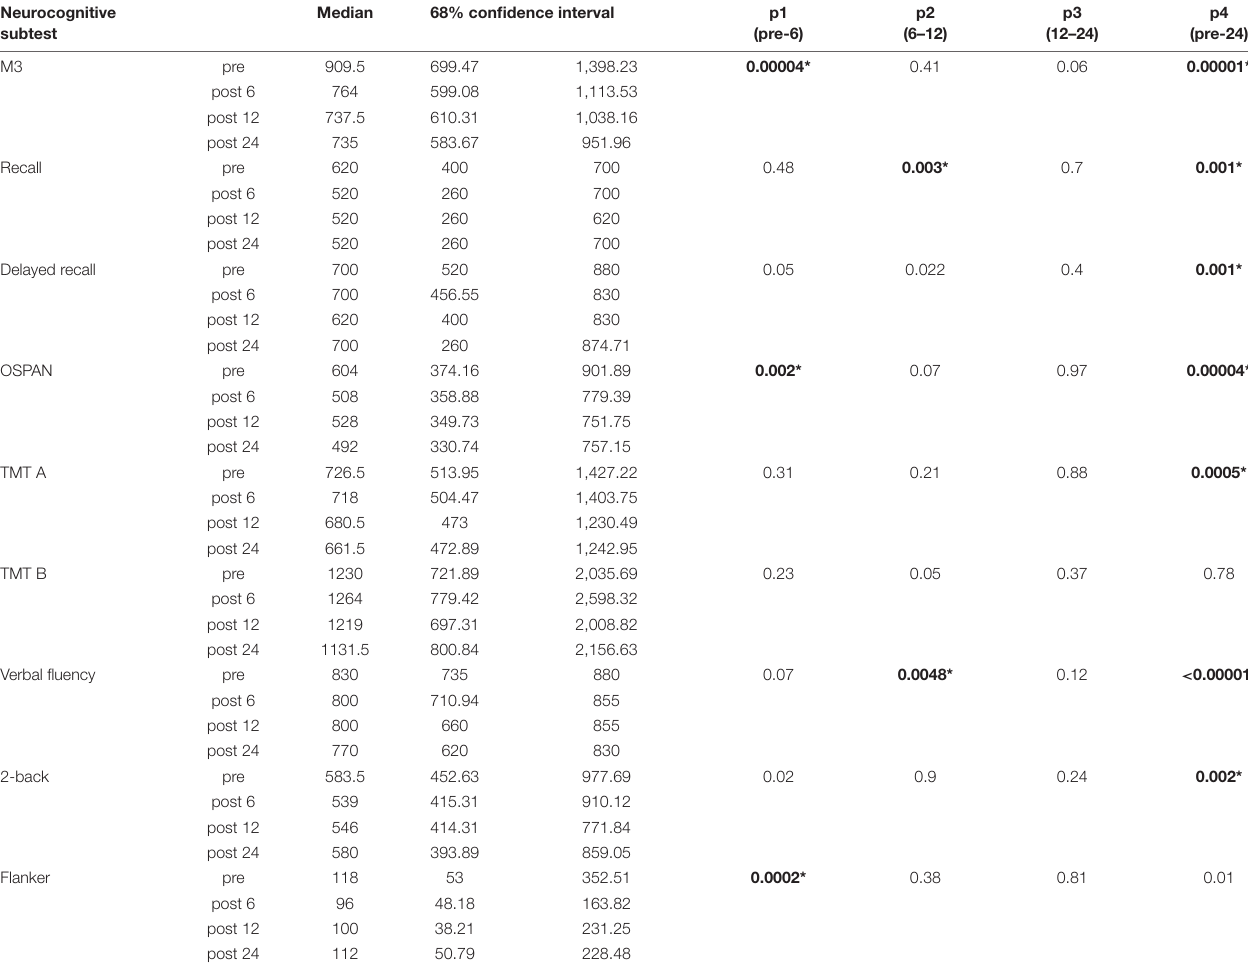
TABLE 2 | Median of the inverse efficiency (IE) and 68% confidence interval of the neurocognitive subtests. Neurocognitive subtest